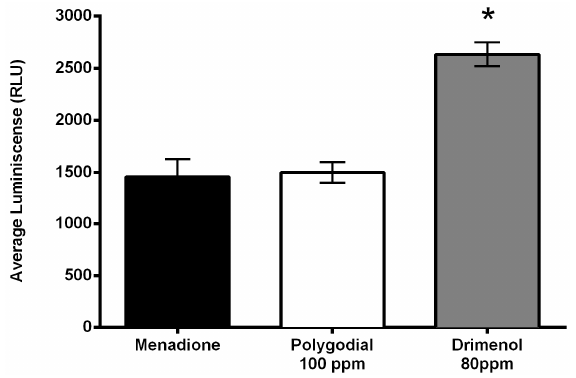
Figure 7. Effect of polygodial on production of reactive oxygen species by Botrytis cinerea . Measured luminescence was converted to concentration of H 2 O 2 after background correction using a standard curve. Menadione (10 ppm final concentration) was used as positive control. (*) represents significant difference between mean of drimenol and means of the other two, at the 0.05 significance level. Data are from Robles-Kelly et al. [19].